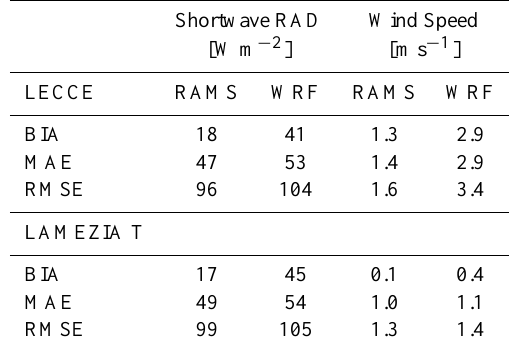
Table 1. RMSE, MAE and BIAS for Lecce and Lamezia Terme and for each model. Statistics are computed starting from hourly data for the six-month period summer-fall